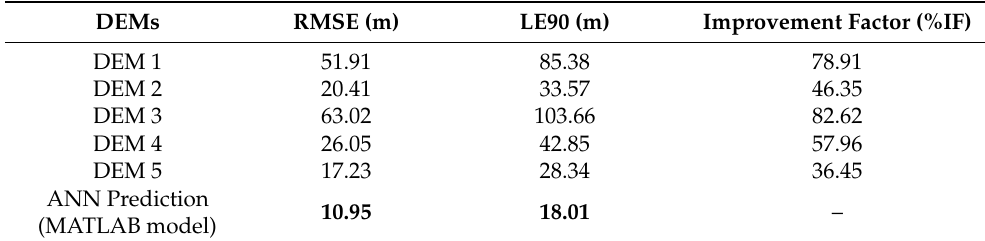
Figure 9 . Fused Output DEM (3D view) for Dehradun and surrounding regions for the depiction of terrain . Table 5. Results for ANN fusion approach for Fused DEM assessed with TanDEM-X 90 m DEM in Dehradun and surrounding regions .